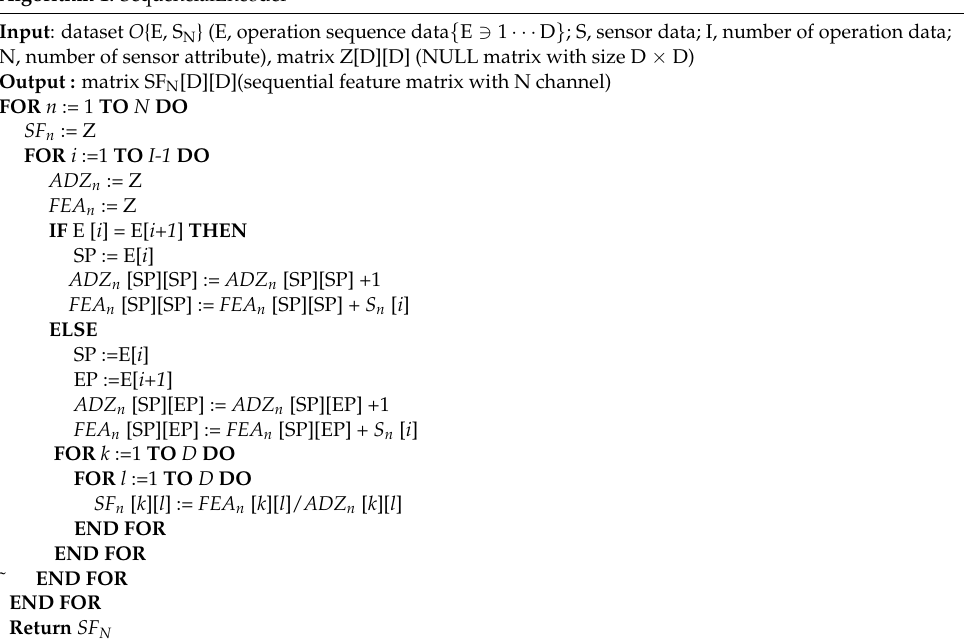
Algorithm 1. Algorithm 1. SequencialEncoder